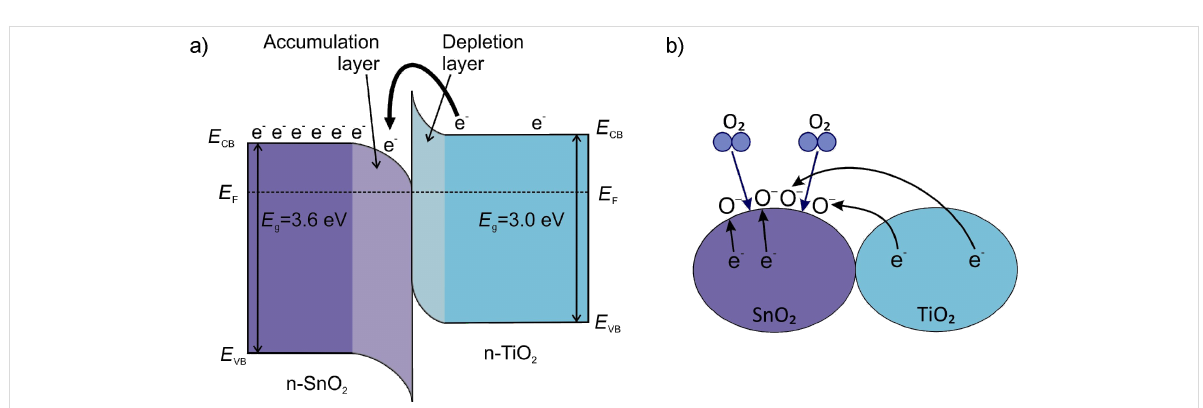
Figure 1: Schematics illustrating the beneficial action of n–n heterojunctions for the sensitization of the gas sensor. (a) Electronic band diagram of an n–n heterojunction, b) electron transfer from a TiO 2 to a SnO 2 grain providing active gas adsorption sites. E F : Fermi energy, E VB : valence band maximum energy, E CB : conduction band minimum energy, E g : energy band gap, e − : electron, O − : singly ionized oxygen